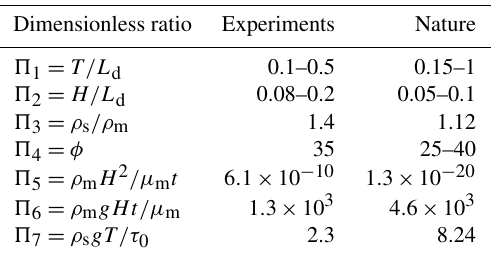
Table 3. Definition and values of the dimensionless ratios (cid:53) in na- ture and in the experiments.